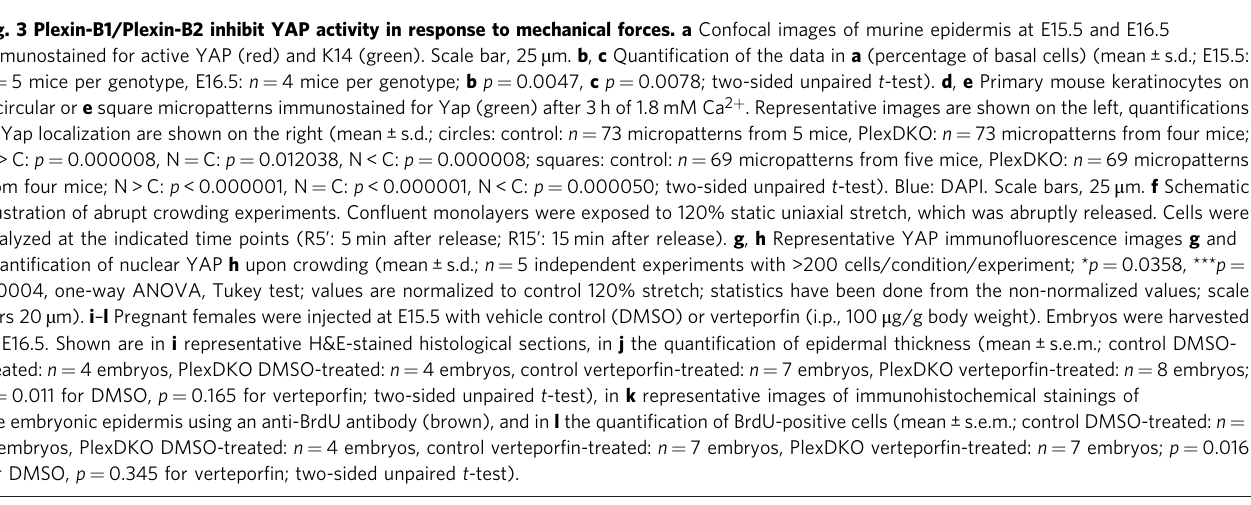
Fig. 3 Plexin-B1/Plexin-B2 inhibit YAP activity in response to mechanical forces. a Confocal images of murine epidermis at E15.5 and E16.5 immunostained for active YAP (red) and K14 (green). Scale bar, 25 µ m. b , c Quanti fi cation of the data in a (percentage of basal cells) (mean ± s.d.; E15.5: n = 5 mice per genotype, E16.5: n = 4 mice per genotype; b p = 0.0047, c p = 0.0078; two-sided unpaired t -test). d , e Primary mouse keratinocytes on d circular or e square micropatterns immunostained for Yap (green) after 3 h of 1.8 mM Ca 2 + . Representative images are shown on the left, quanti fi